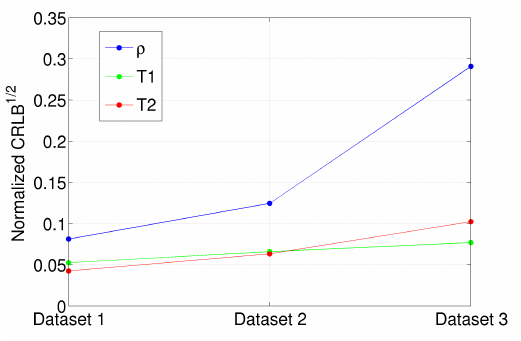
Figure 8. Square root of the CRLB for proton density (blue), spin-lattice ( T time (green) and spin-spin ( T ) relaxation time (red) for the dataset with different acquisition 2 parameters. CRLBs values have been normalized for the parameter values in order to be plotted in the same graph.